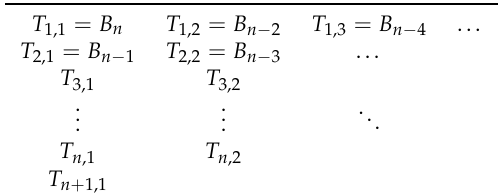
Table 1. Modified Routh